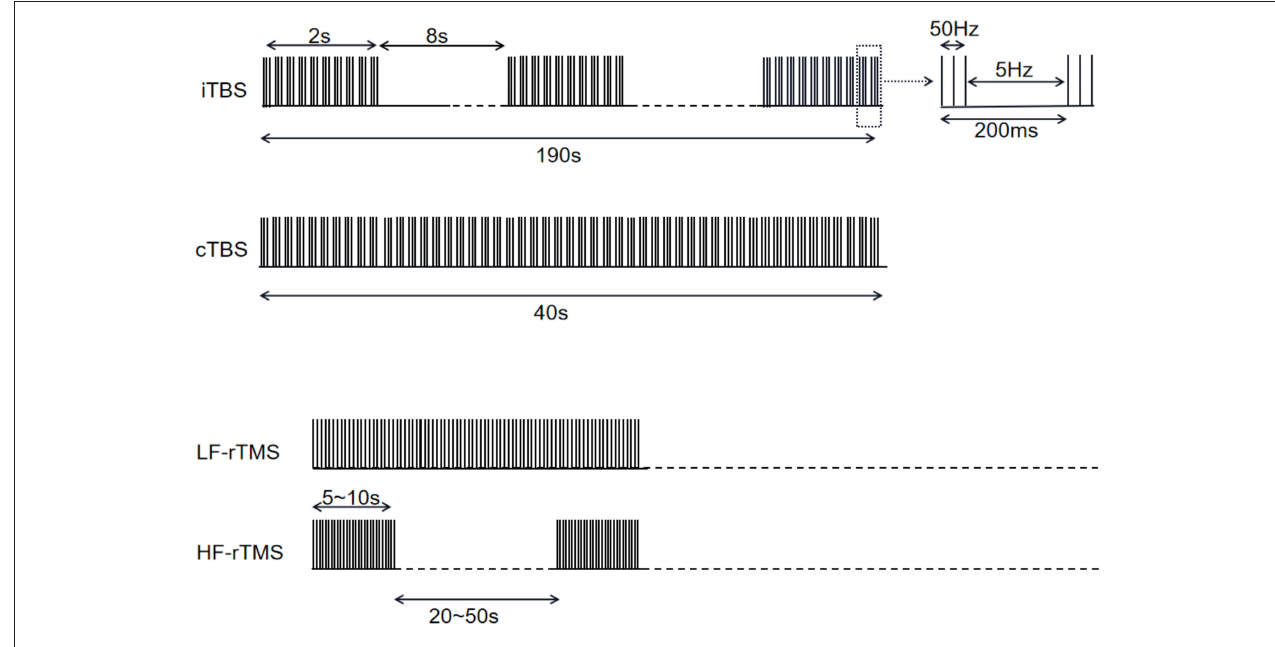
FIGURE 1 | Overview of stimulation modes in studies mentioned in Tables 1 , 2